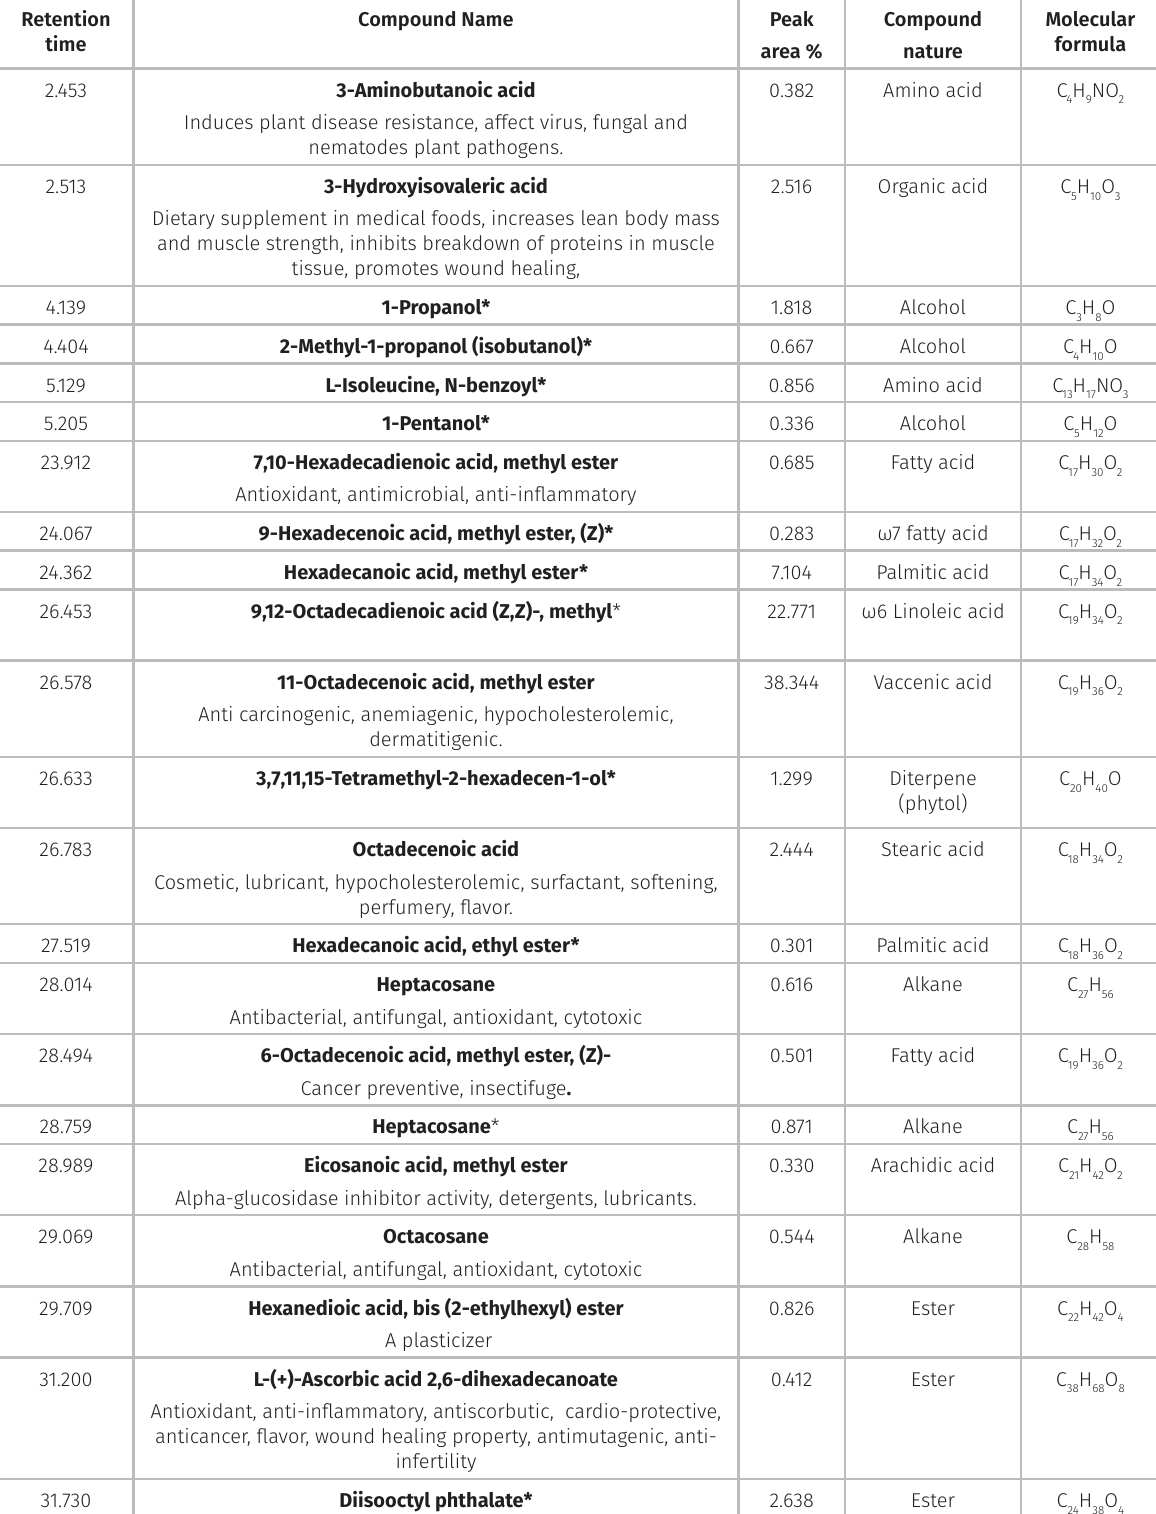
Table VII. GC-MS analysis of Oscilatoria acuminata methanolic extract**.